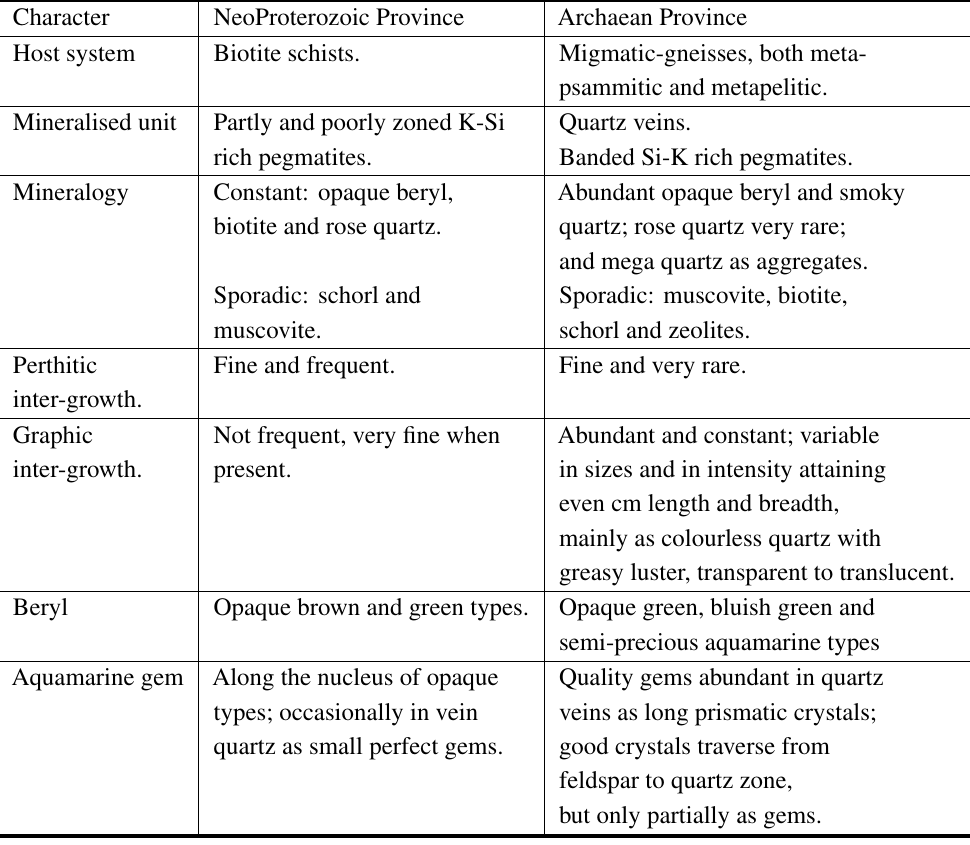
Comparison of the aquamarine